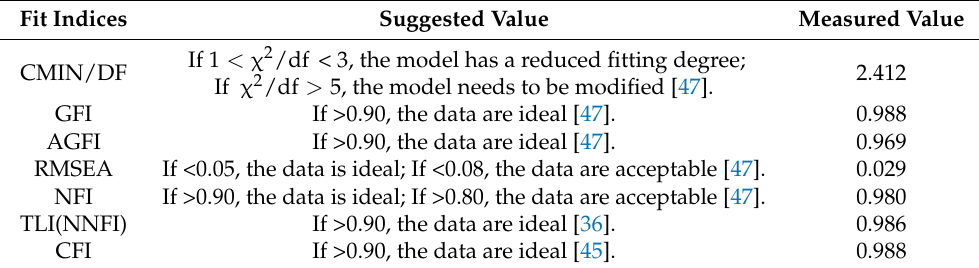
Table A4. Results of the model fit evaluation.